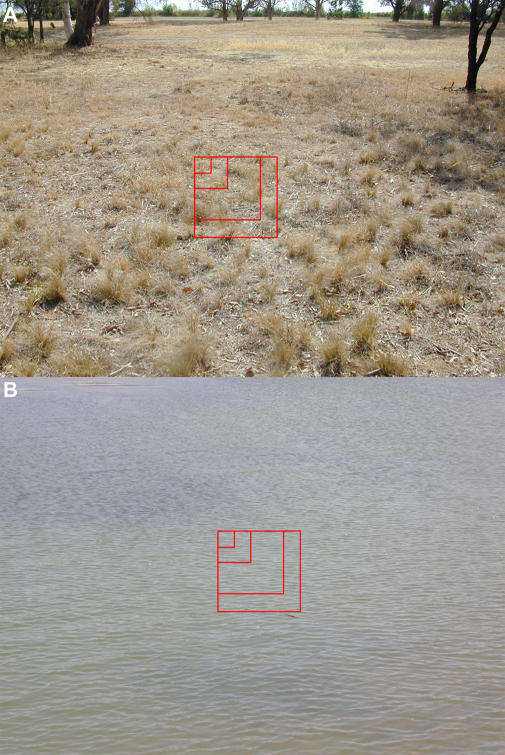
Land and Water TerrainExamples of scenes over land (A) and water (B) that were photographed and analyzed for mean contrast within windows of various sizes, as illustrated by the red boxes in the center of the photographs. Results are given in Tables 1 and 2.